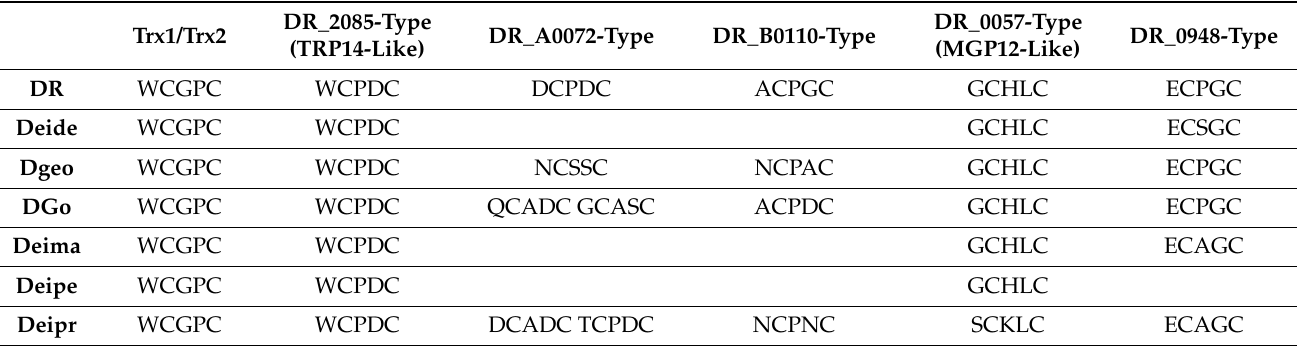
Table 3. Active site motifs in Deinococcus Trx and Trx-like